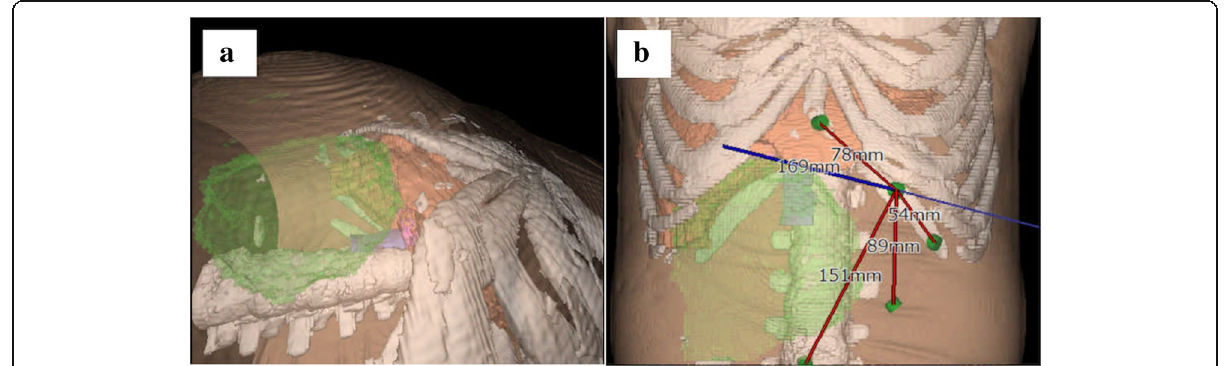
Fig. 2 Preoperative three-dimensional simulation images. a Reconstructed laparoscopic view from the left upper abdomen. b Port placement and the minimal straight parenchymal cutline were